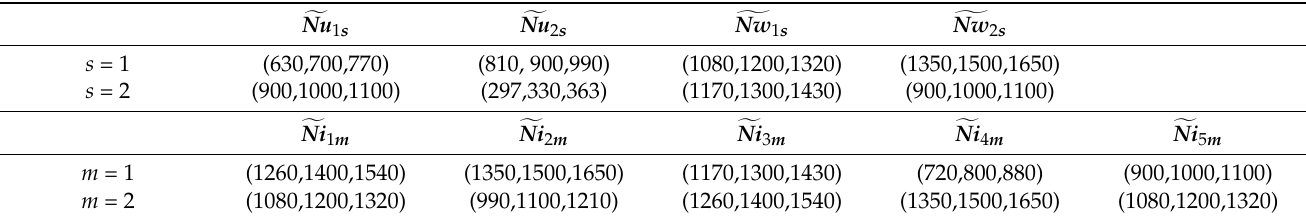
Table 13. Maximum demand at secondary and main markets (unit).